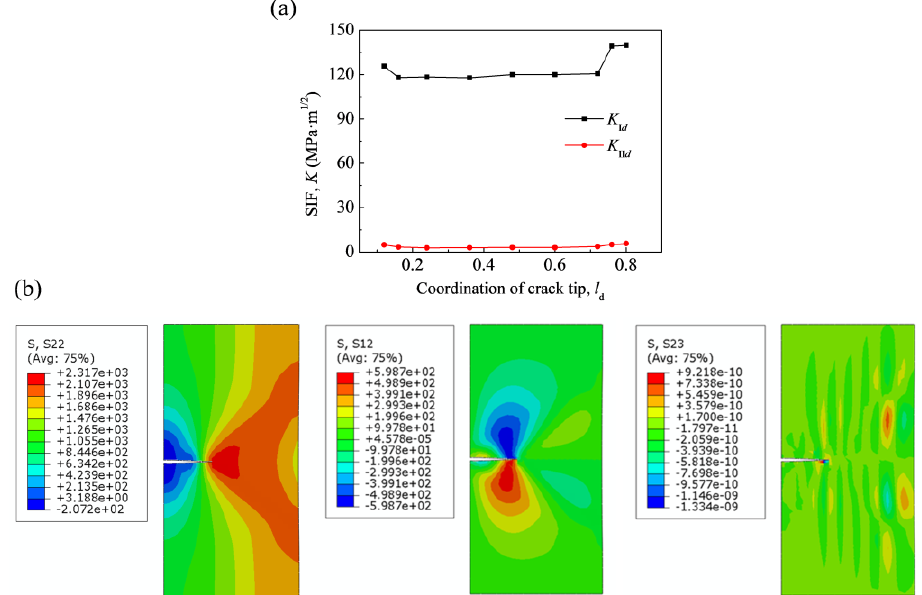
Figure 4. Comparison of ( a ) SIFs, ( b ) stress contours when the crack propagates to 0.4 with the initial crack length 0.1.